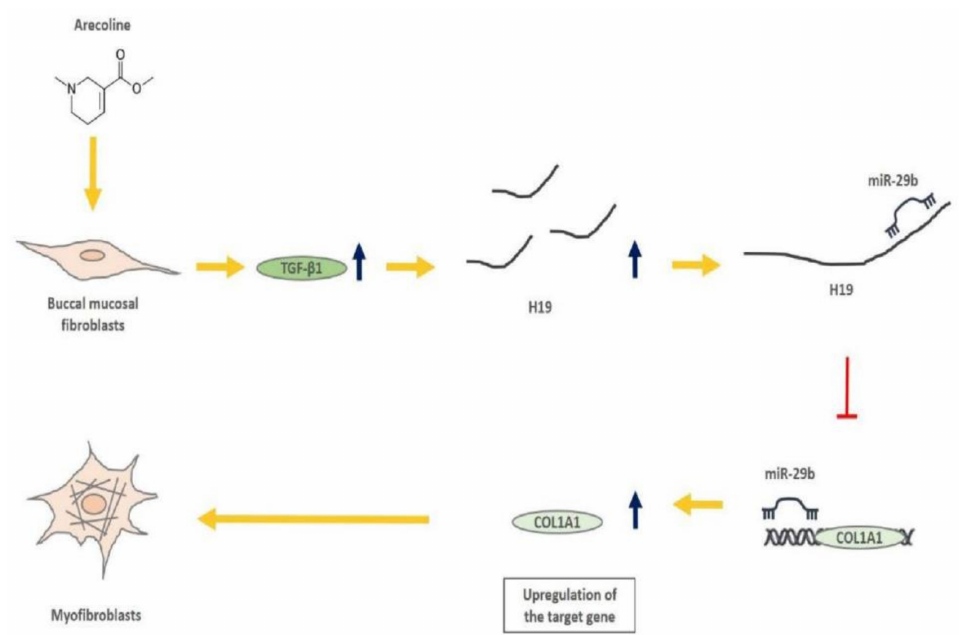
Figure 7. Possible mechanism for the areca nut-associated OSF. This study connects current knowl- edge and demonstrates that the upregulation of TGF- β by arecoline stimulation induces the ex- pression of lncRNA H19 , which sequesters miR - 29b and impedes its binding of type 1 collagen 1. Moreover, suppression of the inhibitory effect of miR - 29b on various fibrosis markers (such as type 1 collagen 1, α -smooth muscle actin, and fibronectin) results in transdifferentiation of buccal mucosal fibroblasts into